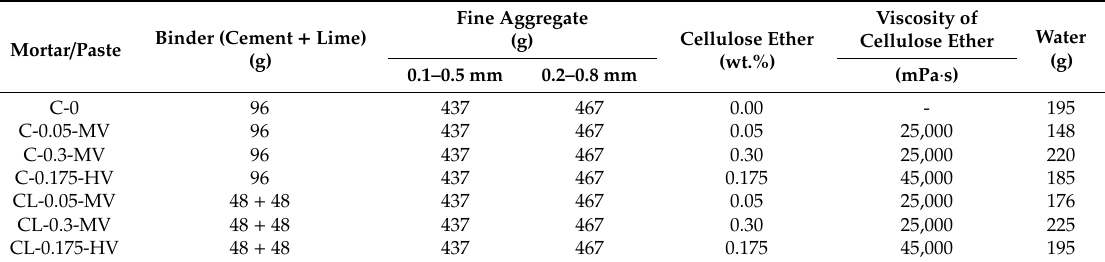
Table 3. Composition of